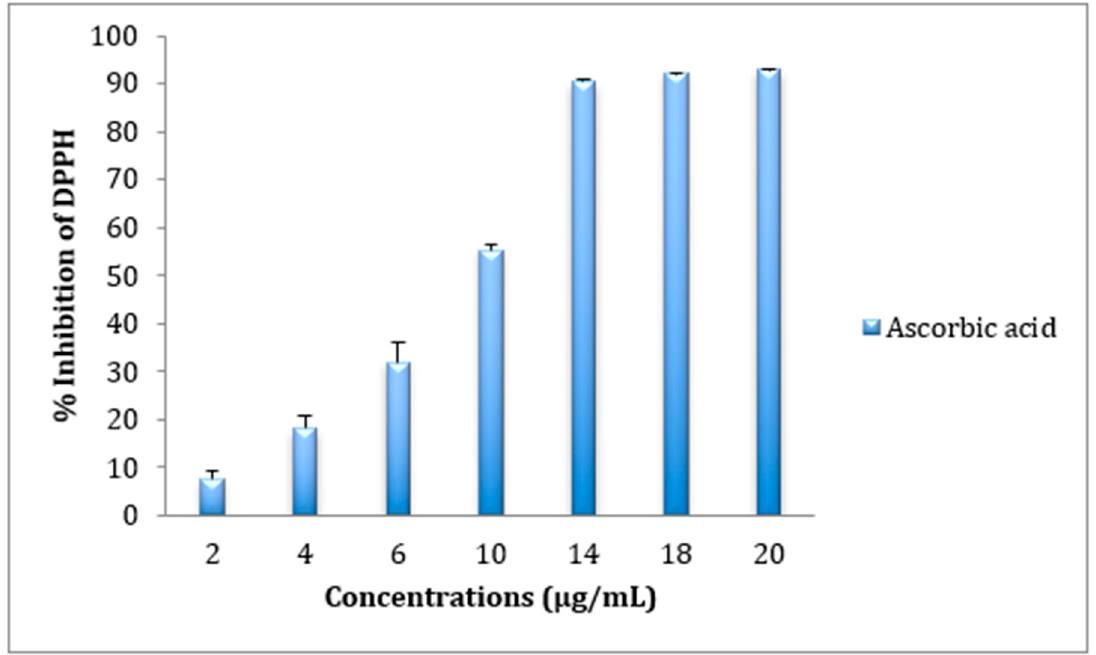
Figure 2. DPPH radical scavenging activity of positive control Ascorbic acid.